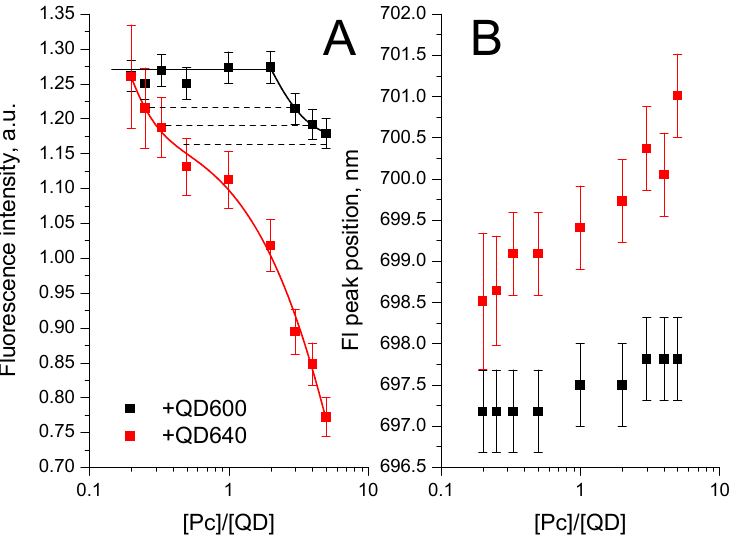
Figure 4. Area under the fluorescence spectrum ( A ) and position of the fluorescence peak ( B ) of AlPc8 in solutions with different concentrations of QD600/QD640. The concentration of Pc at all points is the same and equals 0.2 nM. Pc fluorescence is normalized by values in a solution without QDs. Fluorescence excitation wavelength is 655 nm.